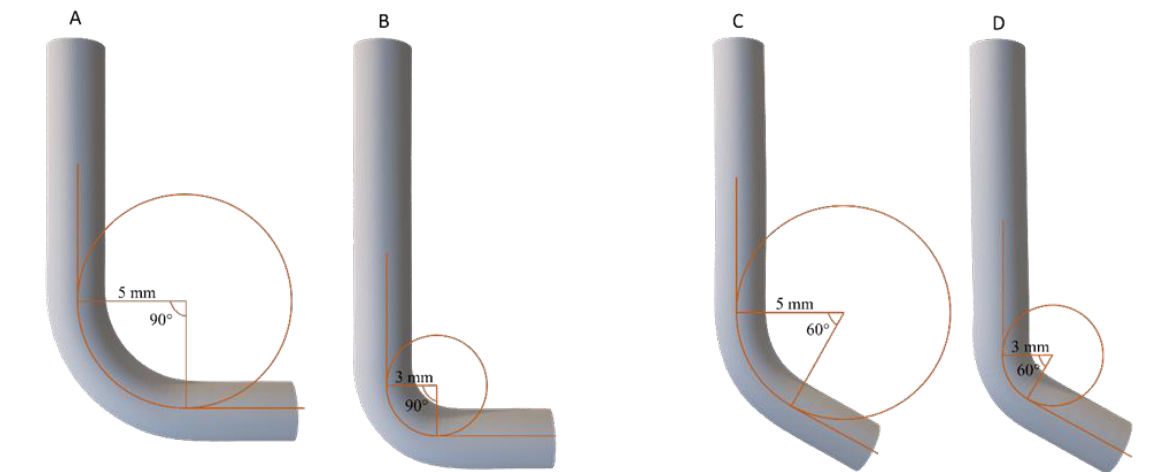
Figure 1. Schematic representation of the four curved artificial canals with different angles and radii of curvature used in the torsional tests, which allowed instruments to remain flexed during test procedures. ( A ) SS canal with the radius of curvature of 5 mm and the degrees of curvature of 90 ◦ ; ( B ) SS canal with the radius of curvature of 3 mm and the degrees of curvature of 90 ◦ ; ( C ) SS canal with the radius of curvature of 5 mm and degrees of curvature of 60 ◦ ; ( D ) SS canal with the radius of curvature of 3 mm and the degrees of curvature of 60 ◦